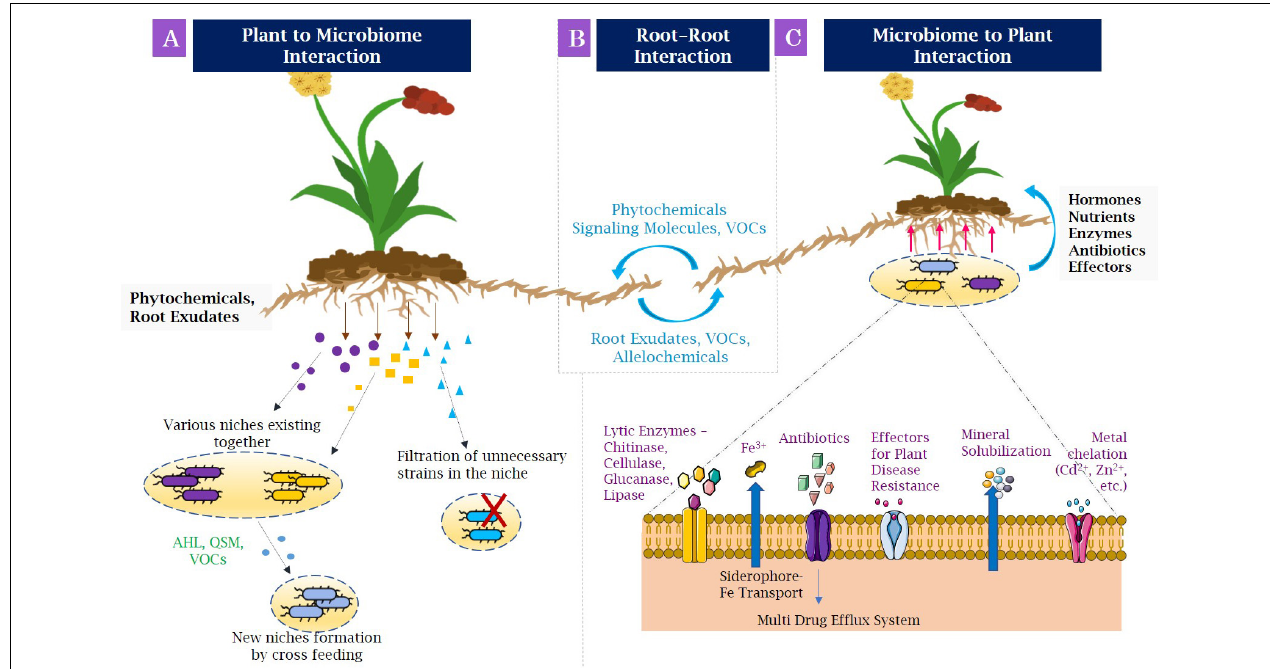
FIGURE 2 | Interactions in the rhizosphere, (A) Plant–microbiome interactions: Plant roots secrete root exudates and phytochemicals that engage microbial populations in developing niches. Some metabolites filter out the unnecessary microbial strains occupied in niches (indicated by red cross), whereas some metabolites allow the different microbial population to coexist in same niche that may secrete compounds needed for growth of other microorganisms. (B) Root–root interactions: The neighboring plants may associate with other forming beneficial, as well as competing interactions by allelochemicals, root exudates, and volatile organic compounds. (C) Microbiome–plant interactions: Beneficial bacteria allow the promotion of plant growth by various mechanisms, such as making nutrients available by chelating them and transporting to plants (for example, siderophore-Fe transporter to carry utilizable iron); and producing phytohormones, such as indole acetic acid, secreted effectors, and antibiotics to protect plants from pathogens. AHL, N -acyl homoserine lactone; QSM, quorum-sensing molecules; VOCs, volatile organic compounds; Fe, iron; Cd, cadmium; Zn,